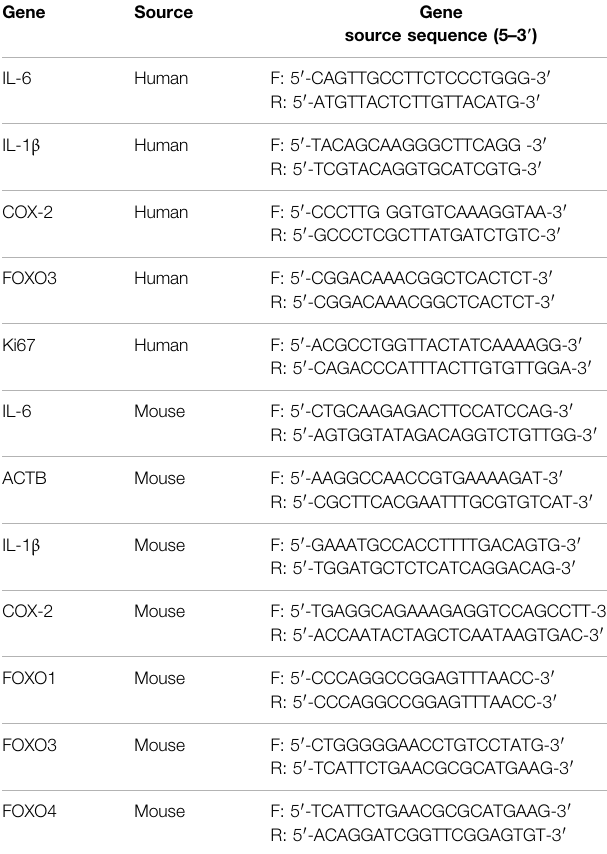
TABLE 1 | Primers list for